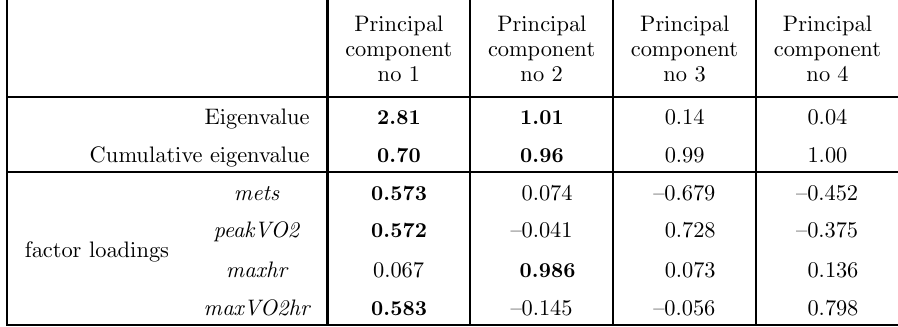
Table 10. Contribution of eigenvalues for principal components in total sample variance division and factor loadings for the four principal components Principal Principal